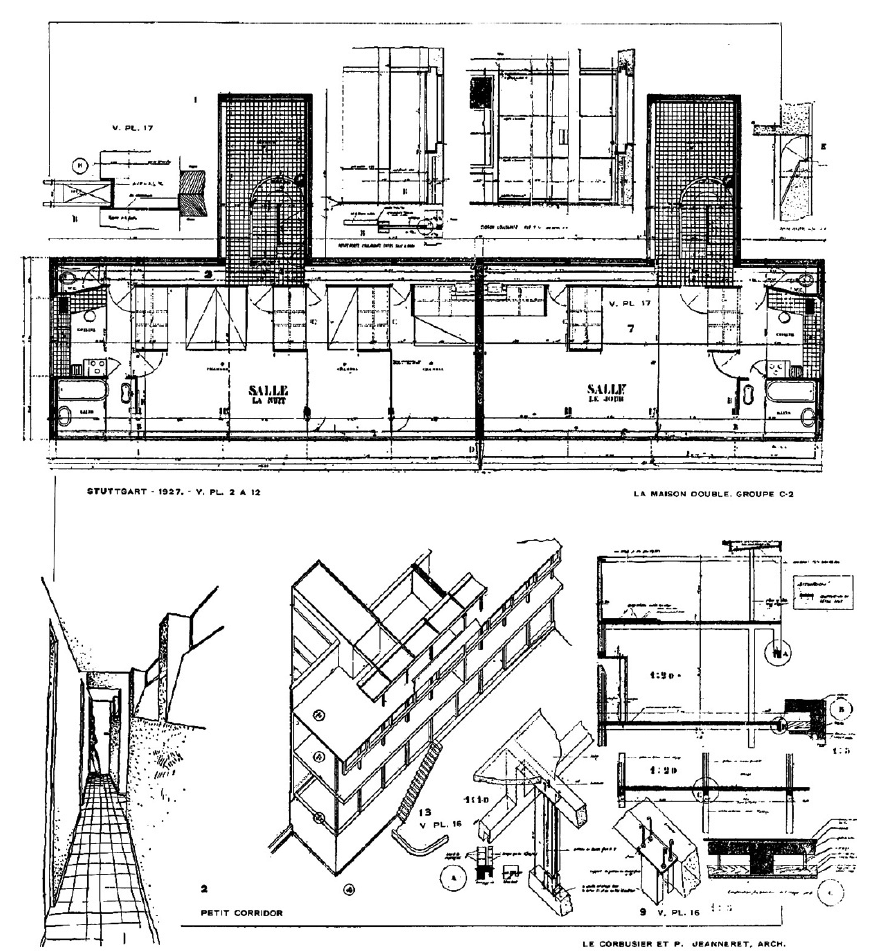
Figure 6. Le Corbusier, two-storey (duplex) housing units at Weissenhof, plan and details, 1927. Source: Le Corbusier (1928). Image copyright: © FLC/2019, ProLitteris,